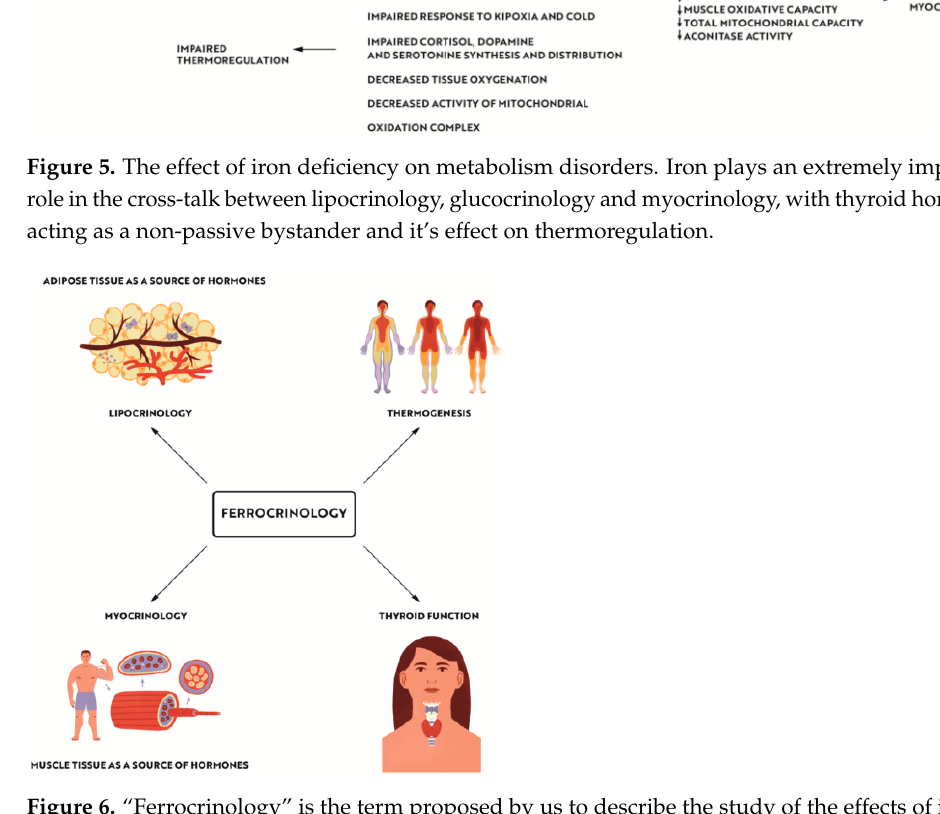
Figure 6. “Ferrocrinology” is the term proposed by us to describe the study of the effects of iron on metabolism disorders, endocrinopathies as AITD and mutual interactions of adipose and muscle tissues with it's influence on thermoregulation disturbances. Author Contributions: Conceptualization: M.S. And E.B.-S.; validation: M.S. and W.M.; investiga- tion: M.S.; resources: M.S., writing—original draft preparation: M.S. and W.M.; writing—review and editing: M.S. and K.G.-N.; supervision: E.B.-S. All authors have read and agreed to the pub- lished version of the manuscript. Funding: This research received no external funding Institutional Review Board Statement: Not applicable. Informed Consent Statement: Not applicable.